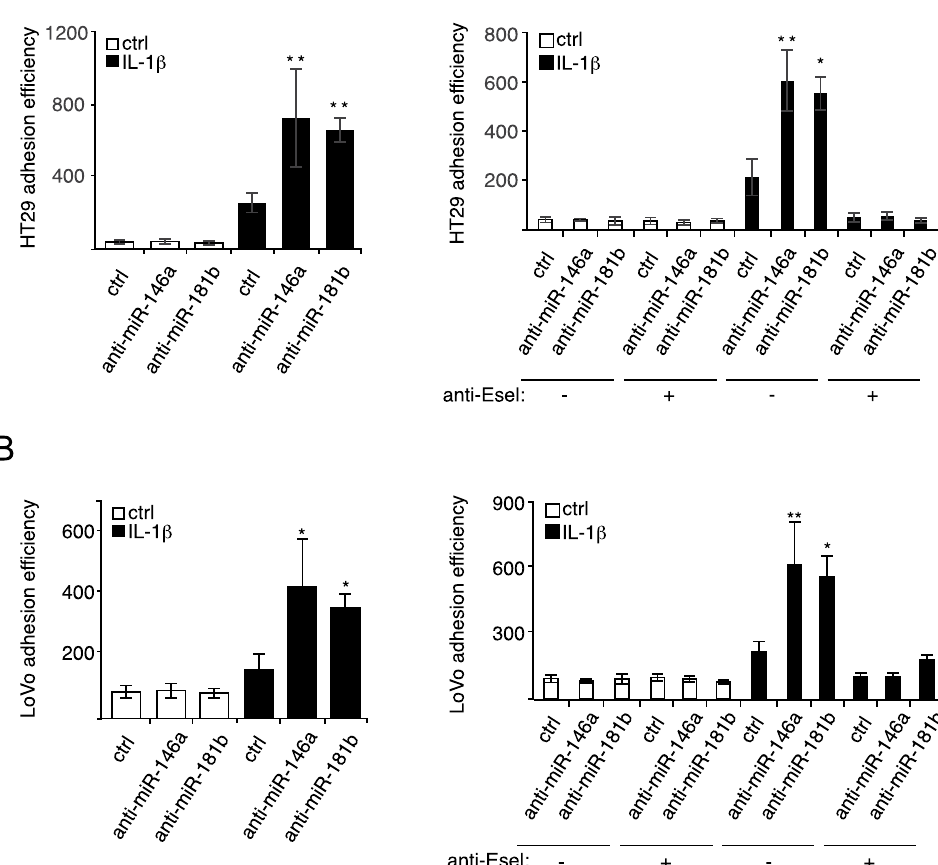
Figure 3. miR-146a and miR-181b modulate E-selectin-mediated adhesion of metastatic colon cancer cells to endothelial cells. ( A ) MiR-146a and miR-181b inhibit E-selectin-dependent adhesion of HT29 colon cancer cells to endothelial cells. Endothelial cells were transfected and stimulated as described in Fig. 1. Calcein AM- stained HT29 metastatic colon cancer cells were added on the tight layer of endothelial cells and incubated for 30 minutes. Non-adhering cells were washed and cells adhering to endothelial cells were determined. To test the E-selectin dependence of the effect of both miRNAs on cancer cells adhesion, anti-E-selectin antibody or MOPC21antibody (1:40) was added to endothelial cells one hour before the addition of HT29 cells. ( B ) MiR-146a and miR-181b inhibit E-selectin-dependent adhesion of LoVo colon cancer cells to endothelial cells. Experiments were carried out as described in a. Calcein AM-stained LoVo metastatic colon cancer cells were used. The quantification are the mean values of three independent experiments, the error bars represent standard errors of three independent experiments, and the significance was analyzed using a Student’s t-test. The p -values are calculated comparing to the “anti-miR ctrl/IL-1 β (/antibody ctrl)” group ( * p < 0.05; ** p < 0.01). Anti-Esel.: anti-E-selectin